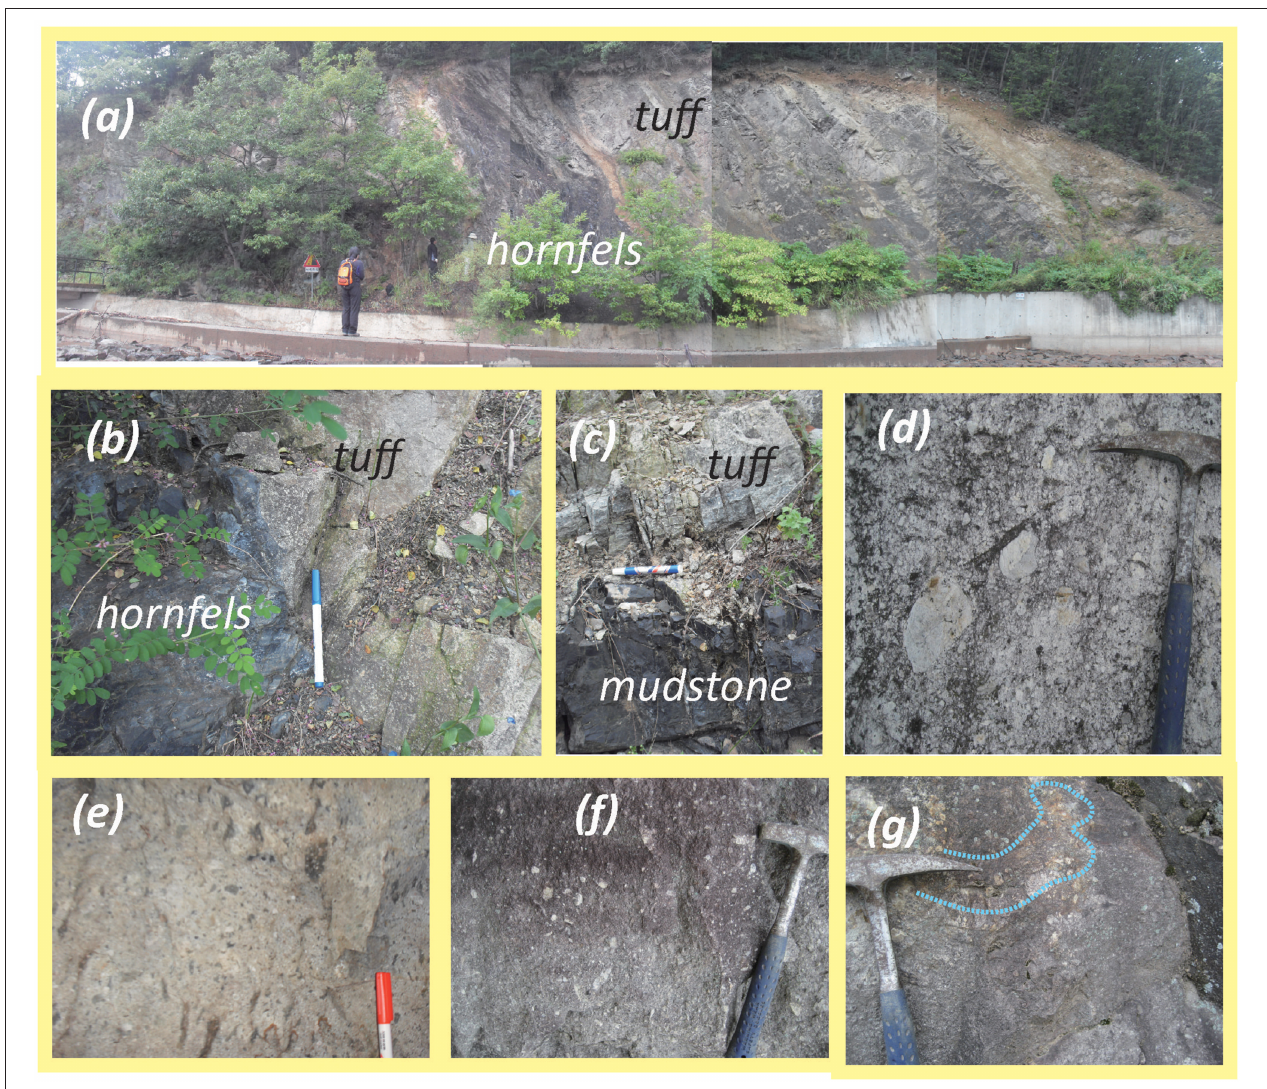
FIGURE 2 | (A) Contact metamorphism produced hornfels along the mudstone-ignimbrite boundaries. (B) Hornfelsic mudstone-ignimbrite boundary in a magnified scale. (C) Dyke-like flames of dark mudstones intrude the tuff layer. (D) Devitrified shards developed in a loosely welded tuff. (E) Pumice-rich tuff contains phenocrysts of resorbed plagioclase. (F) Densely welded lithic-rich tuff. (G) Rheomorphic structure with highly flattened lenticular pumice fragments and concentration of pumice fiammes (highlighted with dashed